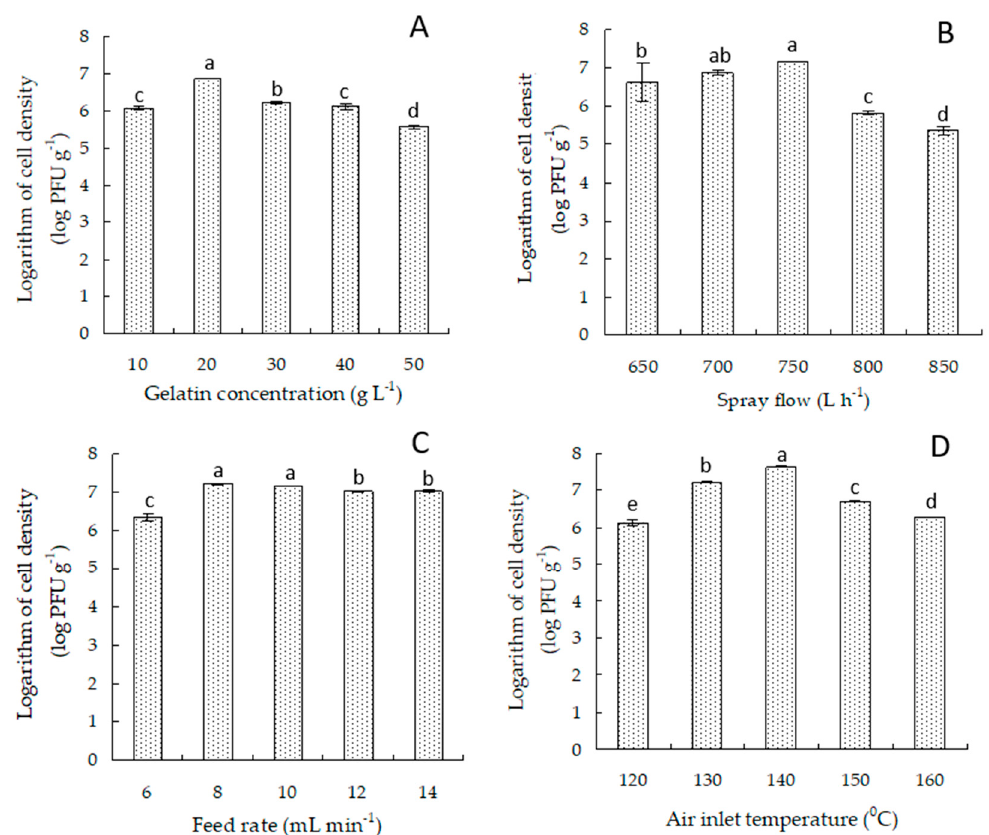
Figure 1. E ff ects of gelatin concentration ( A ), spray flow ( B ), feed rate ( C ), and air inlet temperature ( D ) on cell density of Bdellovibrio sp. strain F16 in the spray-dried powder. Data presented as the mean of triplicate spray-drying trials and standard deviations (SD) are indicated by the vertical bars. Bars with di ff erent lowercase letters are statistically di ff erent ( p <